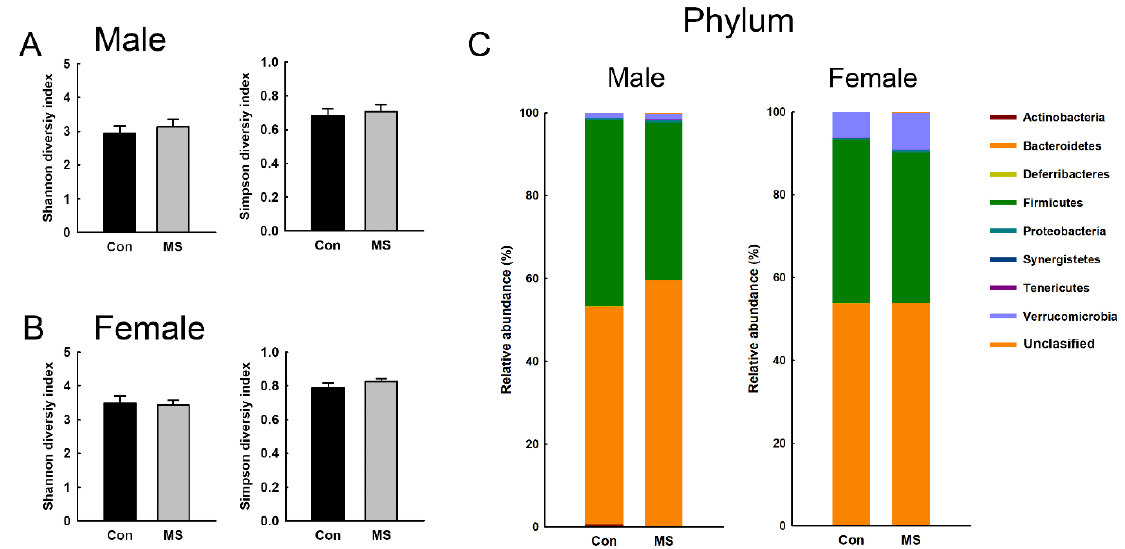
Figure 2. Effect of maternal separation (MS) on fecal microbiota composition at the phylum level. Alpha diversity (Shannon and inversed Simpson indices) in male ( A ) and female rats ( B ). Data are mean ± SEM. ( C ) Mean microbial composition at the phylum level. n = 7 per group.